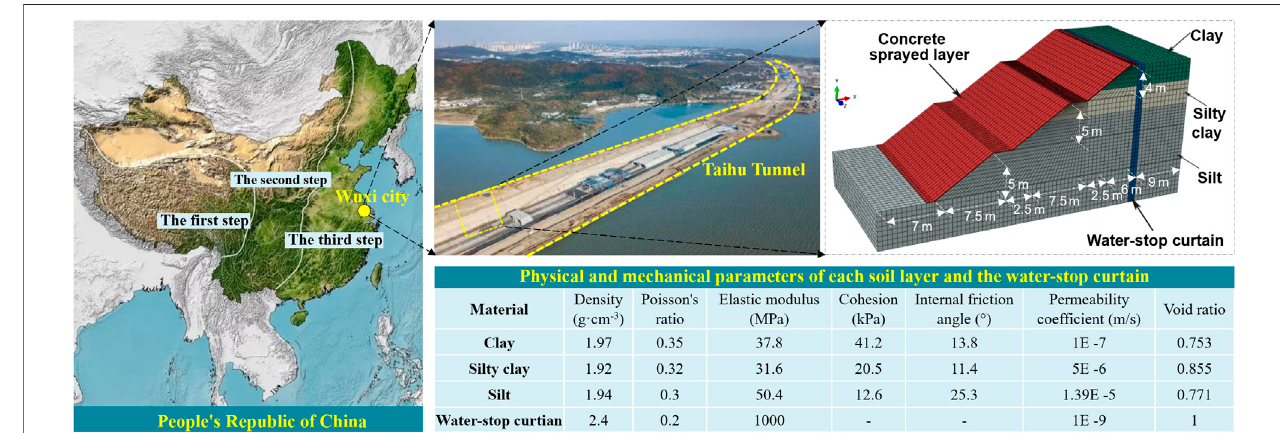
FIGURE 1 | Three-dimensional fi nite element model of the excavation slope located in the Taihu Tunnel, Wuxi